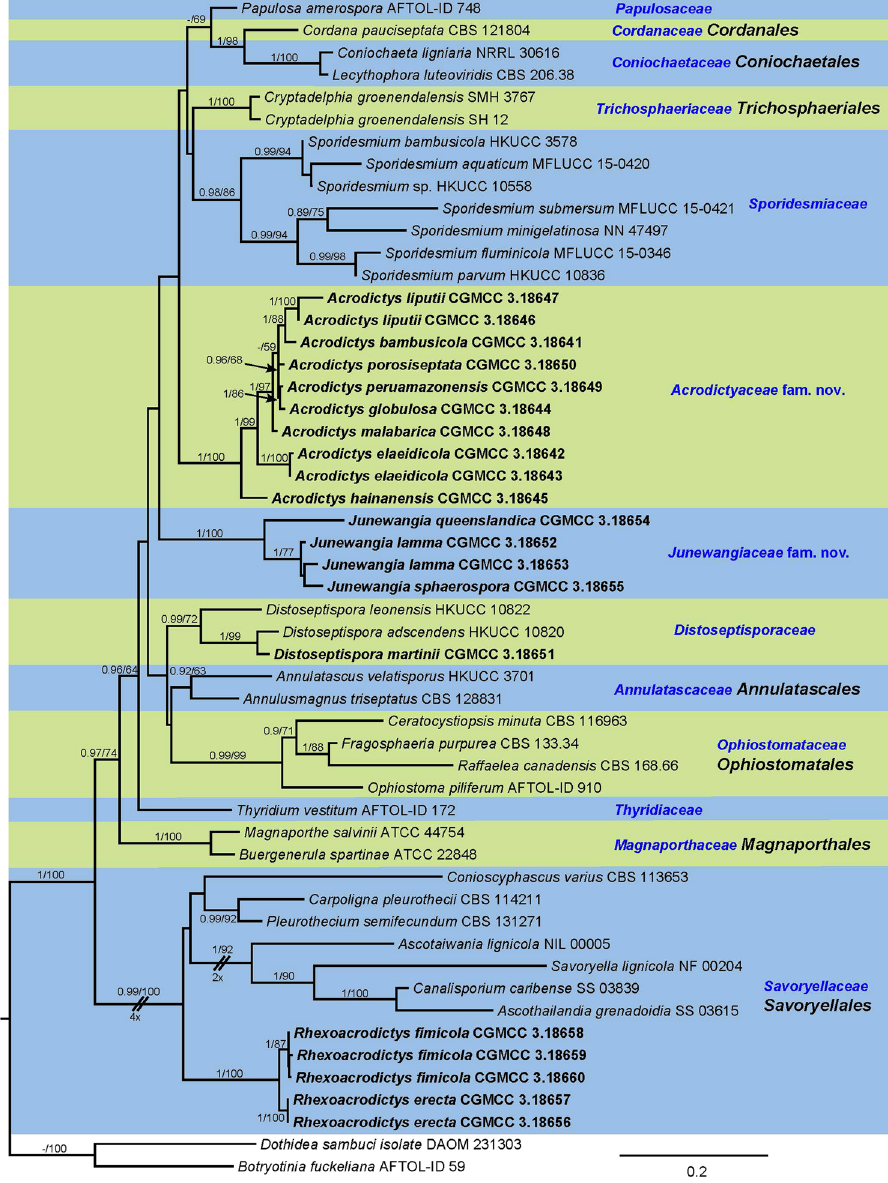
Figure 1. Phylogenetic tree inferred from a Maximum likelihood analysis based on a concatenated alignment of LSU, SSU, ITS and tub2 sequences of 51 strains representing Sordariomycetes. Only high branch support is shown at the nodes, maximum likelihood bootstrap support (MLBS ≥ 50%) and Bayesian posterior probability (PP ≥ 85%). Taxa in bold refer to newly introduced sequence. Some branches were shortened to fit them to the page – these are indicated by two diagonal lines with the number of times a branch was shortened indicated next to the lines. The tree is rooted to Botryotinia fuckeliana and Dothidea sambuci